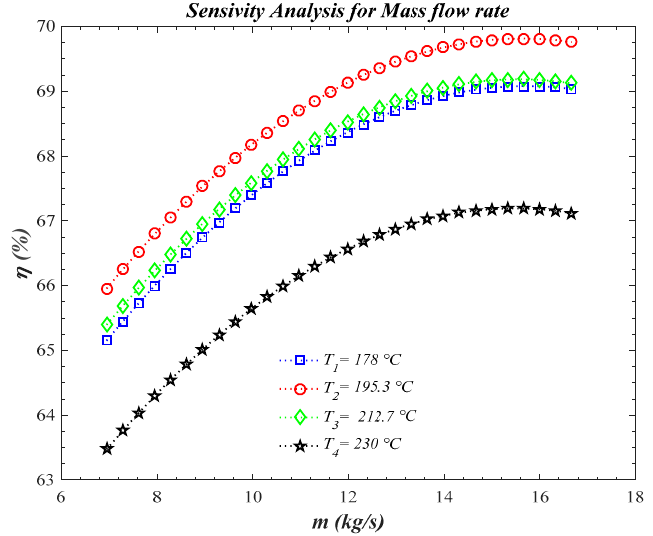
Figure 18. Flow rate sensitivity analysis at four di ff erent